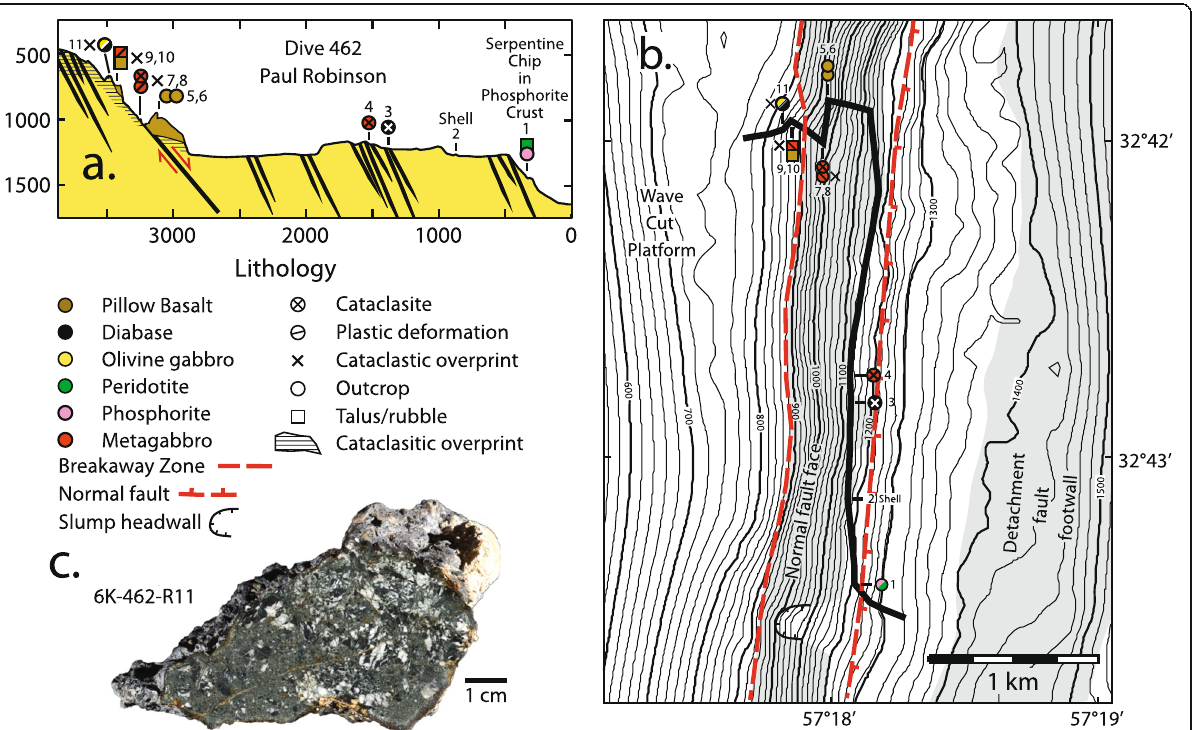
Fig. 28 Geologic interpretation of Shinkai Dive 652 on the eastern upper wall of Atlantis Bank (Fig. 3). Note that an X is placed next to a sample that has undergone crystal-plastic deformation or is a composite sample with two lithologies, so the symbols do not obscure each other. a Profile showing the dive path (distorted so that the same fault scarp appears twice due to the successive east to west, south to north, and east to west submersible track (indicated by the X next to the lithologic symbol. P. T. Robinson diving scientist as indicated in a . b Plan view of the dive showing the detachment fault footwall on the down-dropped bench below the wave-cut platform and the exposed normal fault face. Note that the phosphorite crust includes a small chip of serpentine imbedded in it (not shown). c Metagabbro amphibolite 6K-462-11: a cataclastic breccia or fault gouge with angular, gneissic, amphibolitized, gabbro, and diabase fragments welded in a matrix of 50% lower amphibolite or greenschist facies comminuted mineral fragments. Diabase clasts are only distinguishable in thin